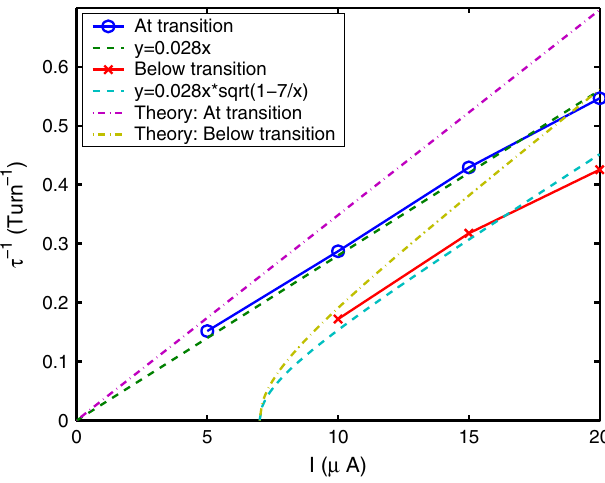
FIG. 12. (Color) Growth rate of the harmonic with (cid:9) ¼ 1 : 5 cm for the isochronous optics and the optics with the negative slip factor (cid:3) 0 : 04 . The simulated data (solid lines with points) is fitted with corresponding fits: y ¼ 0 : 028 x and y ¼ ffiffiffiffiffiffiffiffiffiffiffiffiffiffiffiffiffi p 0 : 028 x 1 (cid:3) 7 =x . Additionally, growth rates calculated directly from Eqs. (14) and (16) for a ¼ 0 : 5 cm and (cid:9) ¼ 1 : 5 are shown. The growth rates predicted by the model exceed the simulated growth rates by approximately 20%.